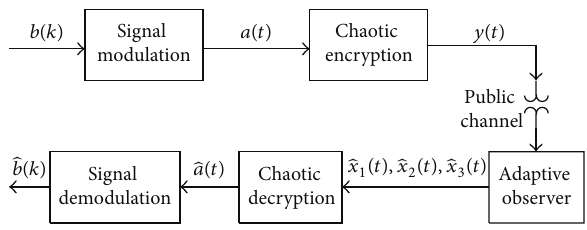
Figure 2: The proposed chaotic secure communication system.